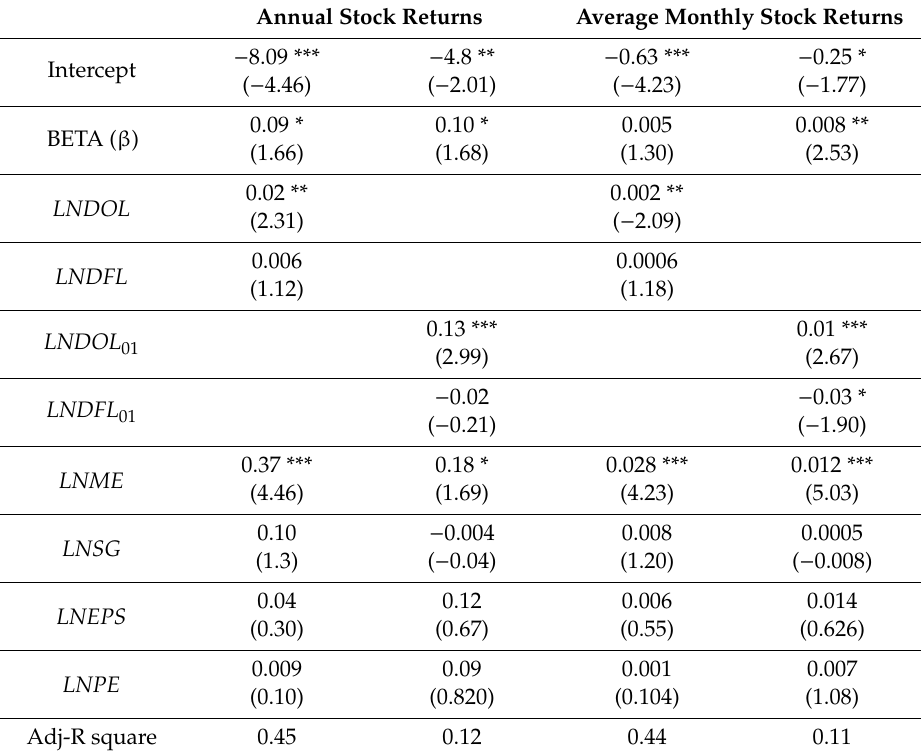
Table 4. Multivariate regression